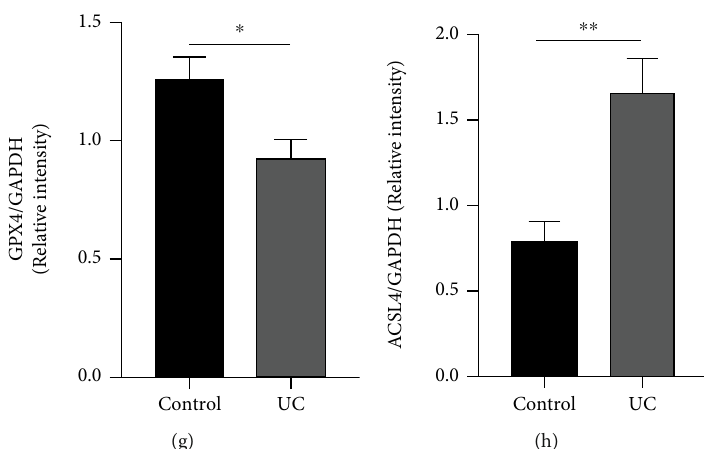
Figure 1: Ferroptosis was involved in the pathogenesis of UC. (a) Iron, (b) GSH levels, and (c) MDA levels were detected in colon samples from the healthy people and UC patients, respectively. (d) Representative images of immunohistochemical analysis measuring GPX4 levels in human colon samples, and (e) quantitative data of cell counts are shown. (f – h) Western blotting analysis of GPX4 and ACSL4. GAPDH was used as the loading control. The p value was determined by unpaired t -test. ∗ p < 0 : 05 , ∗∗ p < 0 : 01 , ∗∗∗ p < 0 : 001 , and ∗∗∗∗ p < 0 : 0001